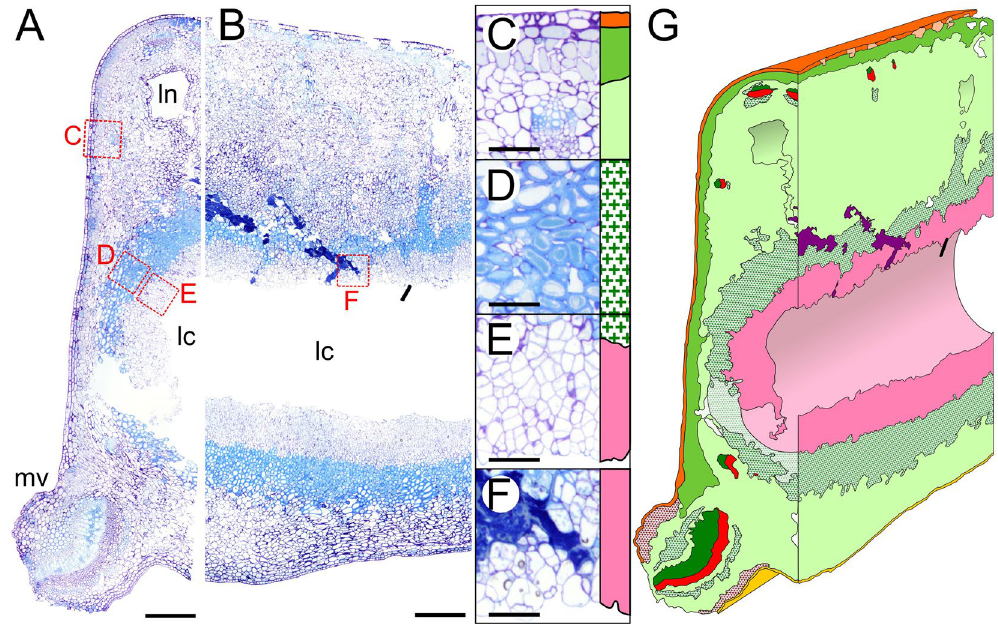
Figure 3. Histological sections and 3D modeling of Caloptilia cecidophora gall at late larval instar. ( A ) Transversal section. ( B ) Sagittal section. ( C ) Detail of gall epidermis. ( D ) Detail of the sclerenchyma. ( E ) Detail of nutritive tissue. ( F ) Detail of insect frass trapped in nutritive tissue. ( G ) 3D modeling of a mature gall based on histology sections. Legend, dark green: xylem, red: phloem, pink: nutritive tissue, green cross: scerenchyma, red cross: colenchyma, purple: frass, lc: larva chamber, ln: lacuna, mv: midvein, for remaining see Fig. 1. Scale: 500 µ m for ( A , B ), 100 µ m from ( C – F ). Staining: Toluidine Blue